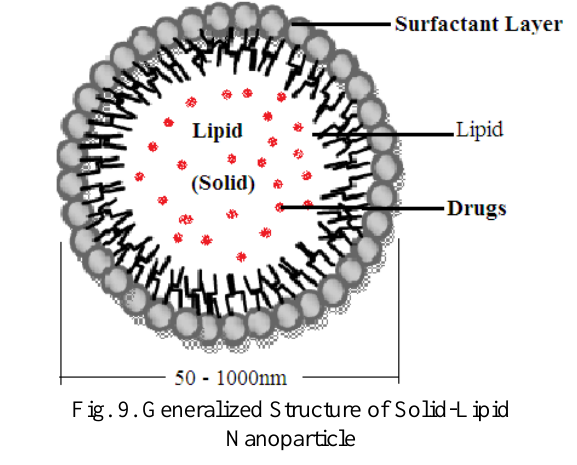
Fig. 9. Generalized Structure of Solid-Lipid Nanoparticle